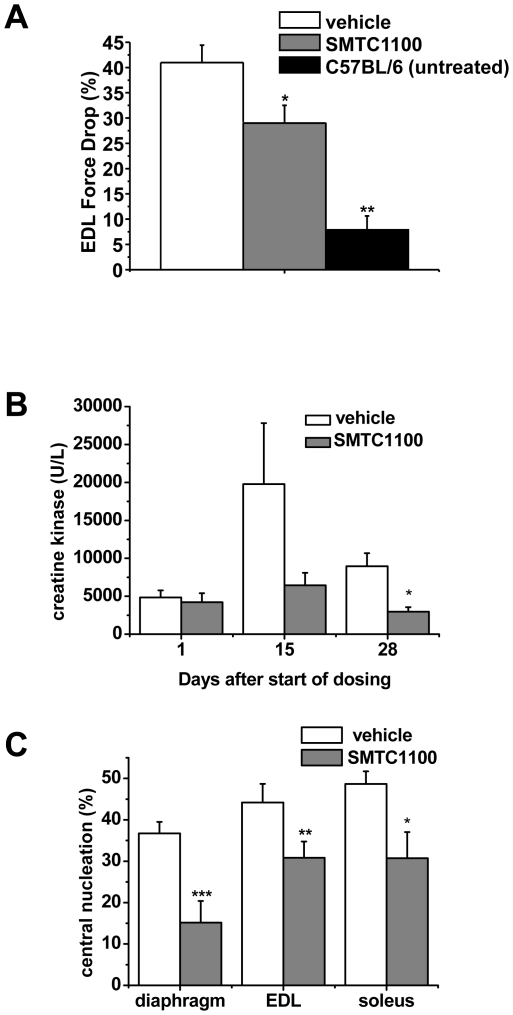

Ex vivo analysis of SMT C1100 activity in the
mdx mouse.(A) mdx mice were treated with SMT C1100 (50 mg/kg/day)
or vehicle only (0.1% Tween-20/5% DMSO in PBS) via daily
i.p. injection from two weeks of age for four weeks. Whilst contracting
tetanically, EDL muscles were stretched at 15% of their fibre
length. The difference in force produced between the first and fifth
stretch is represented as an indicator of the resistance of the muscle
to stretch-induced damage. *p<0.05;
**p<1.0×10−5; (B) levels of serum
creatine kinase following oral gavage of mdx mice with
50 mg/kg SMT C1100 or vehicle from three weeks of age for four weeks (C)
Muscles from the dosing described in (B) were processed to assess the
percentage of centrally nucleated fibres *p<0.01;
(C)***p = 0.0001;
**p = 0.005;
*p = 0.003.